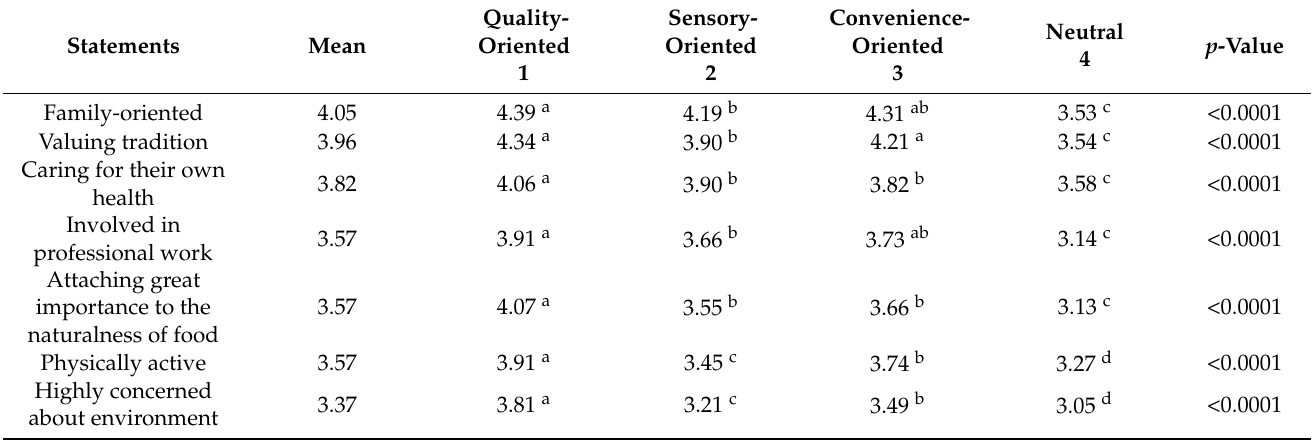
Table 4. Description of segments based on the self-assessed lifestyle of the